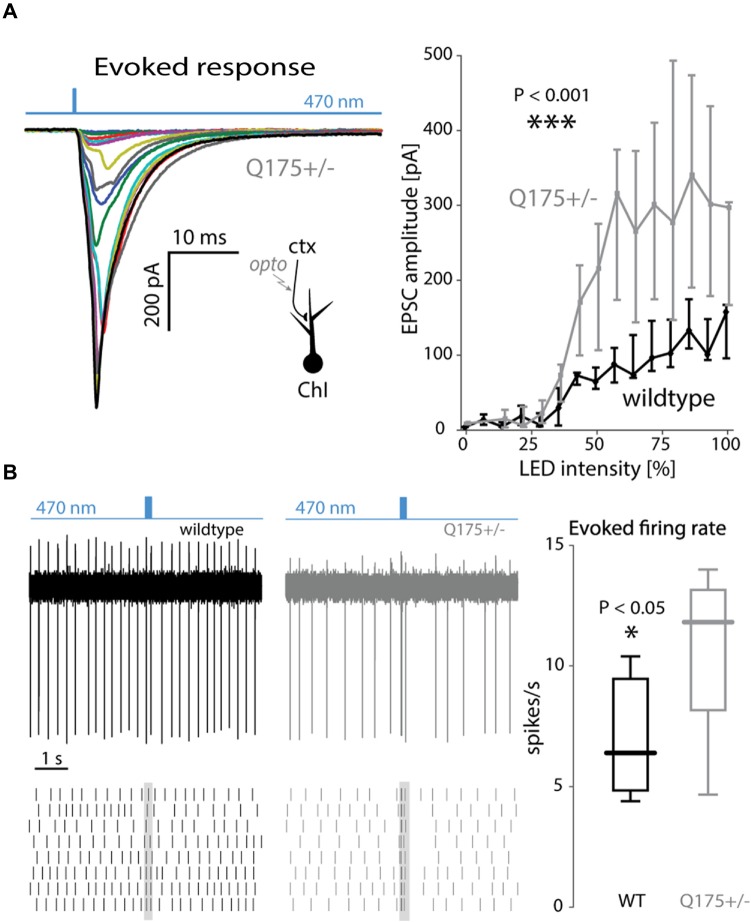
Strong cortical stimulation augmented EPSCs and excitations of ChIs in the Q175 mouse. (A) Left: EPSCs of increasing size in response to increasing LED intensity. Right: summary graph of EPSC amplitude as a function of LED intensity in wildtype (WT) (black trace) and Q175+/− (gray trace) mice. (B) Left: example trace and raster plot of spiking responses in ChIs to trains (20 Hz) of LED pulses in WT (black) and Q175+/− (gray) mice. Right: boxplot of amplitude of evoked spiking responses in ChIs (measured during the duration of the LED pulse train) in both genotypes.